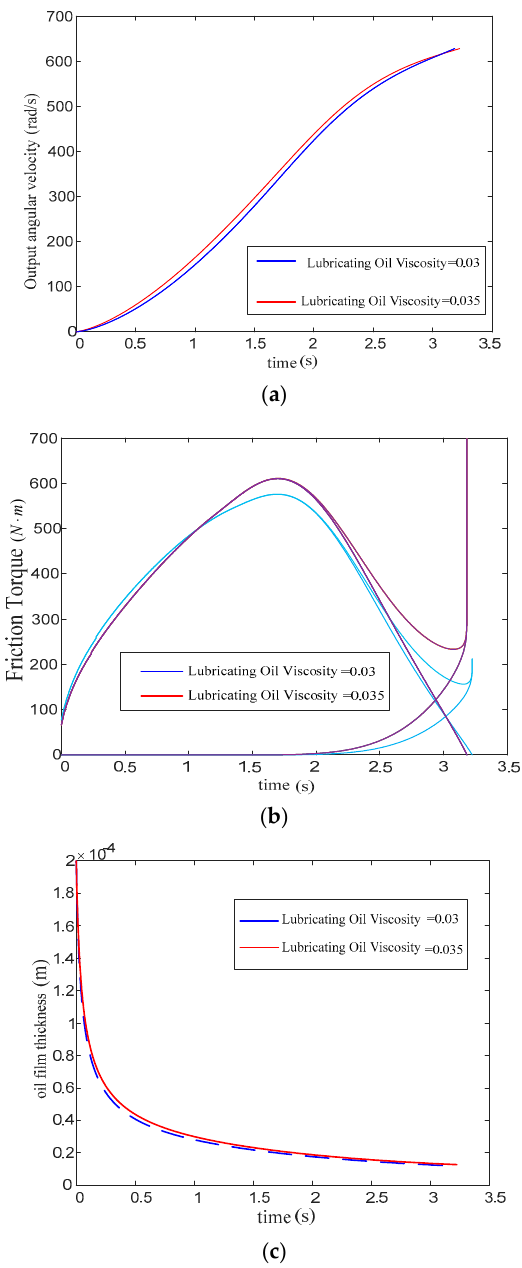
Figure 12. Effect of lubricant viscosity on the output speed, friction torque, and film thickness. ( a ) Effect of lubricant viscosity on the output speed; ( b ) Effect of lubricant viscosity on friction torque; ( c ) Effect of lubricant viscosity on oil film thickness.